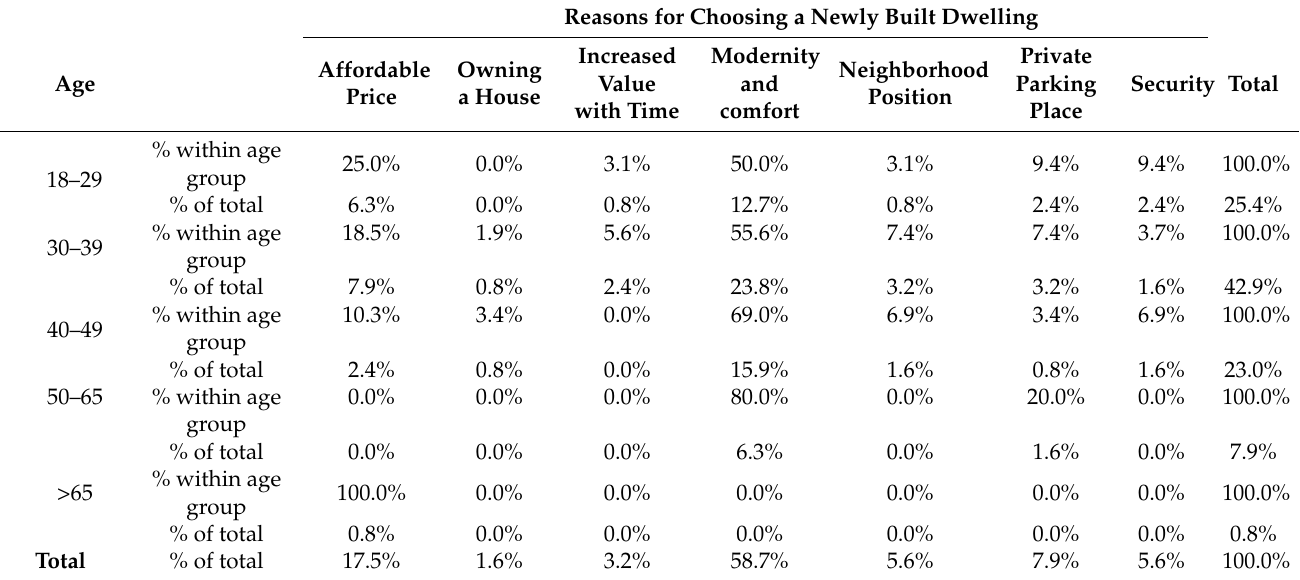
Table 5. Reasons for choosing a newly built dwelling by age